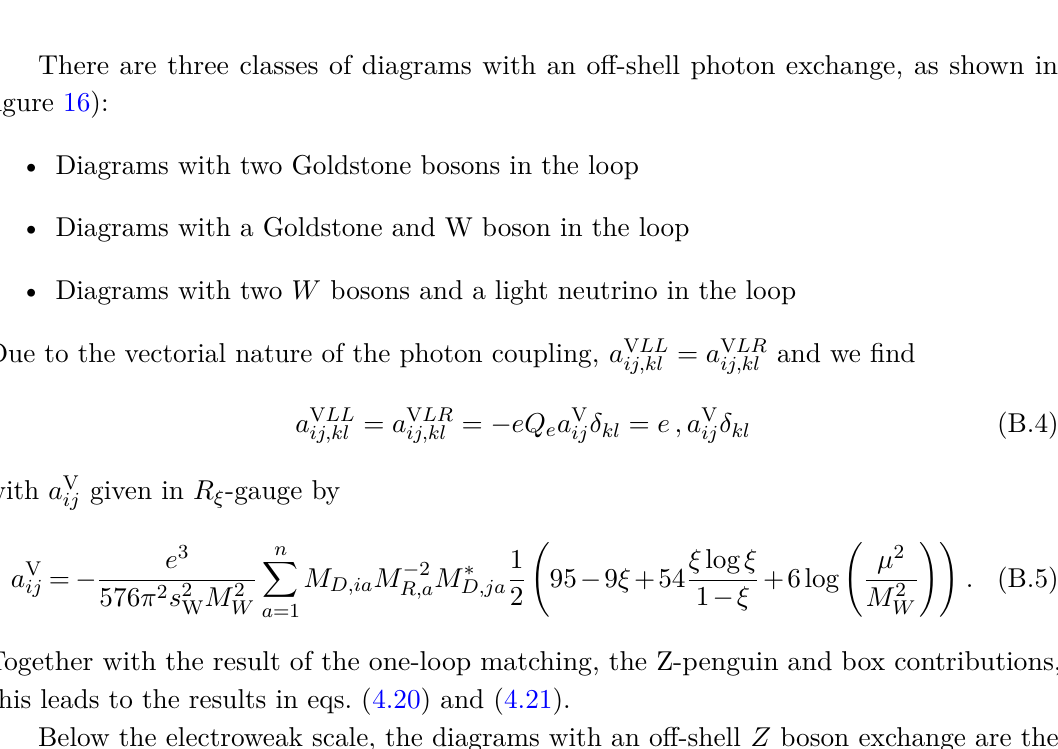
Figure 16. Off-shell photon penguins contributing to four-lepton